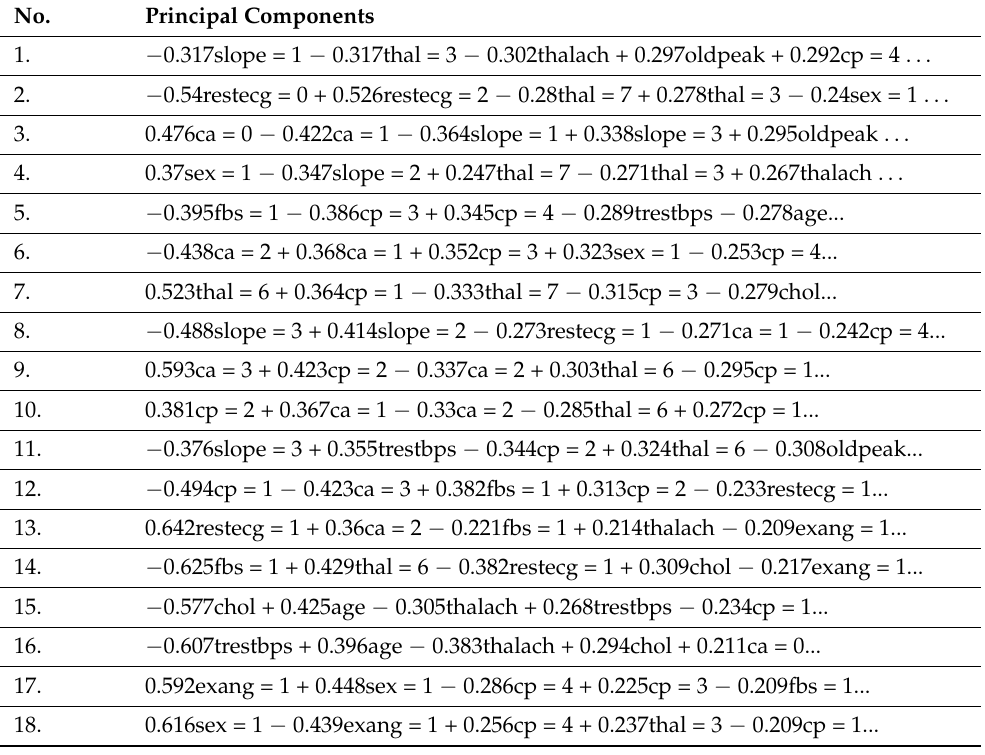
Table 4. Principal components of the combined